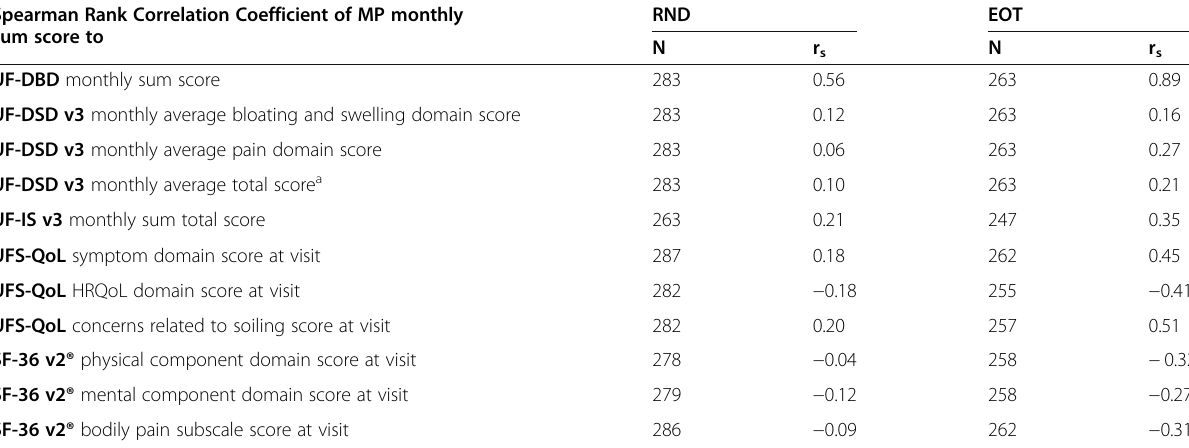
Table 2 Convergent and divergent validity analysis with MP and reference measures (monthly sum scores) Spearman Rank Correlation Coefficient of MP monthly sum score to